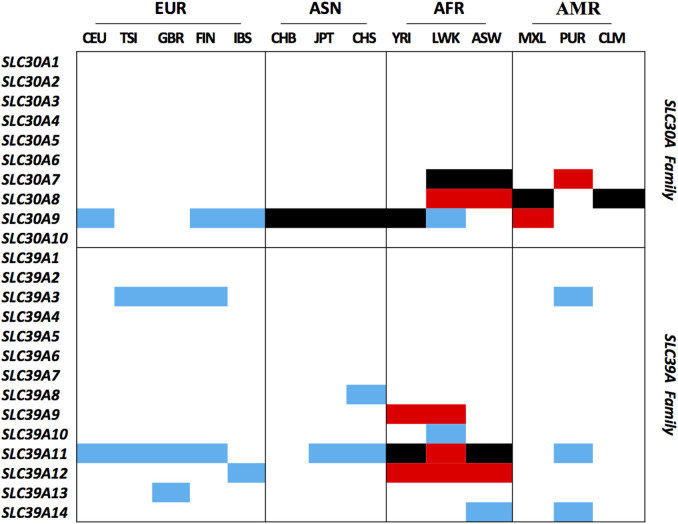
Global natural selection pattern for ZTGs.The blue blocks indicate the significant signals found by the iHS test; the red color indicates the significant signals found by Sweep Finder, and black indicates the overlapping signals for both methods.